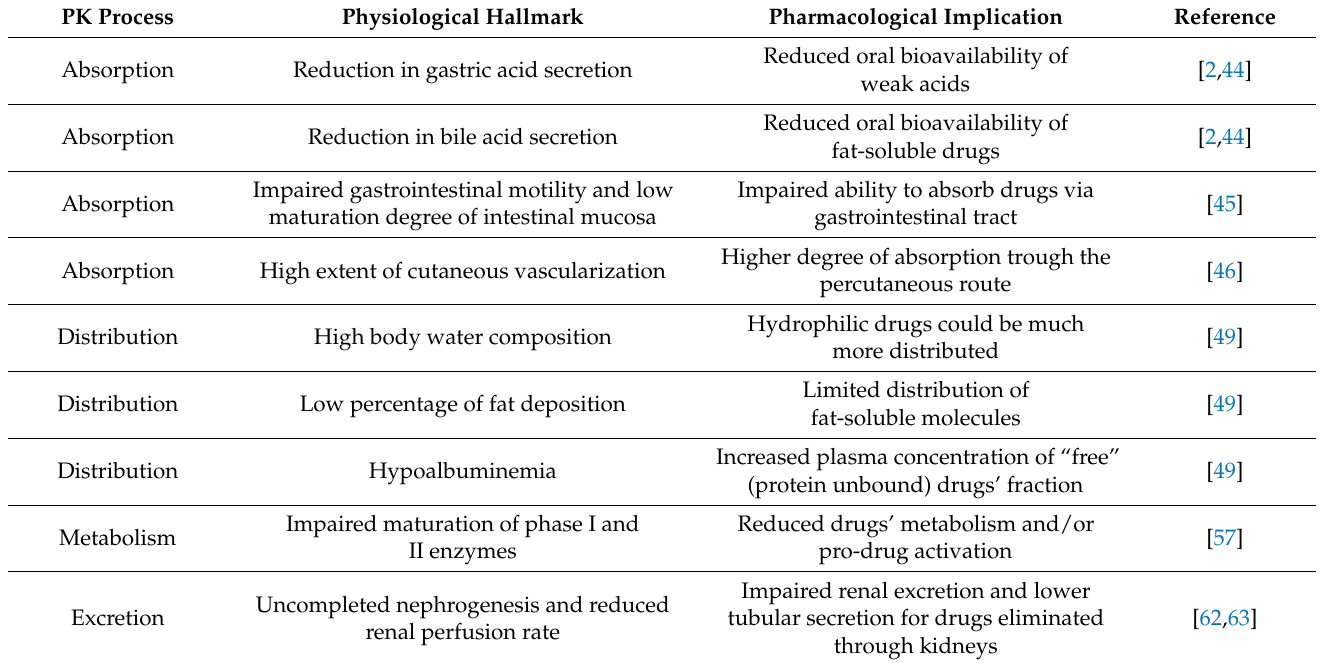
Table 1. Physiological aspects of preterm neonates affecting PK